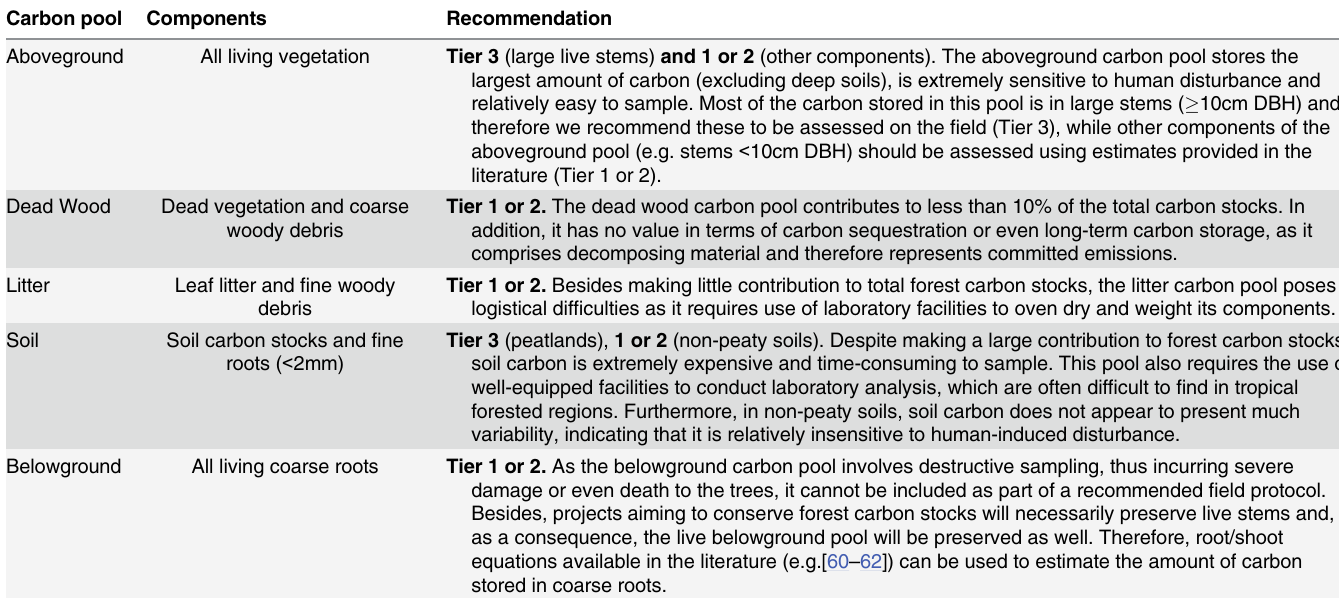
Table 2. Recommended sampling approaches to assess carbon stocks in human-modified tropical forests. Recommendations are based on the results of this study, following the IPCC three- tiers system for forest carbon